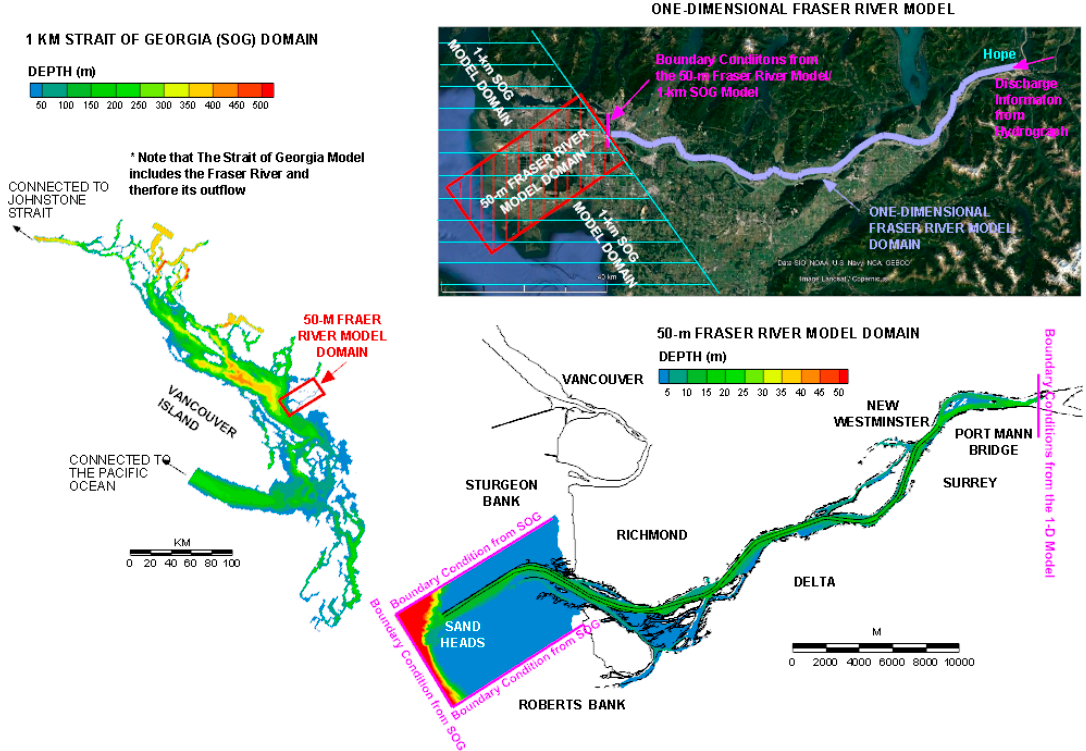
Figure 3. Nesting of the 1-km Strait of Georgia (SOG) model, the 50-m Fraser River model, and the one-dimensional Fraser River model.